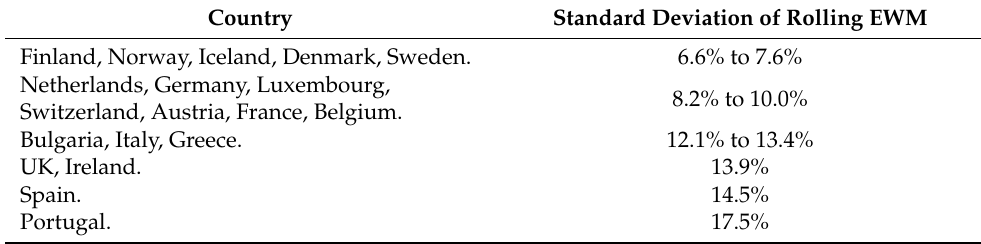
Table 5. European countries ranked according to the standard deviation associated with their rolling EWM (1960–2019).